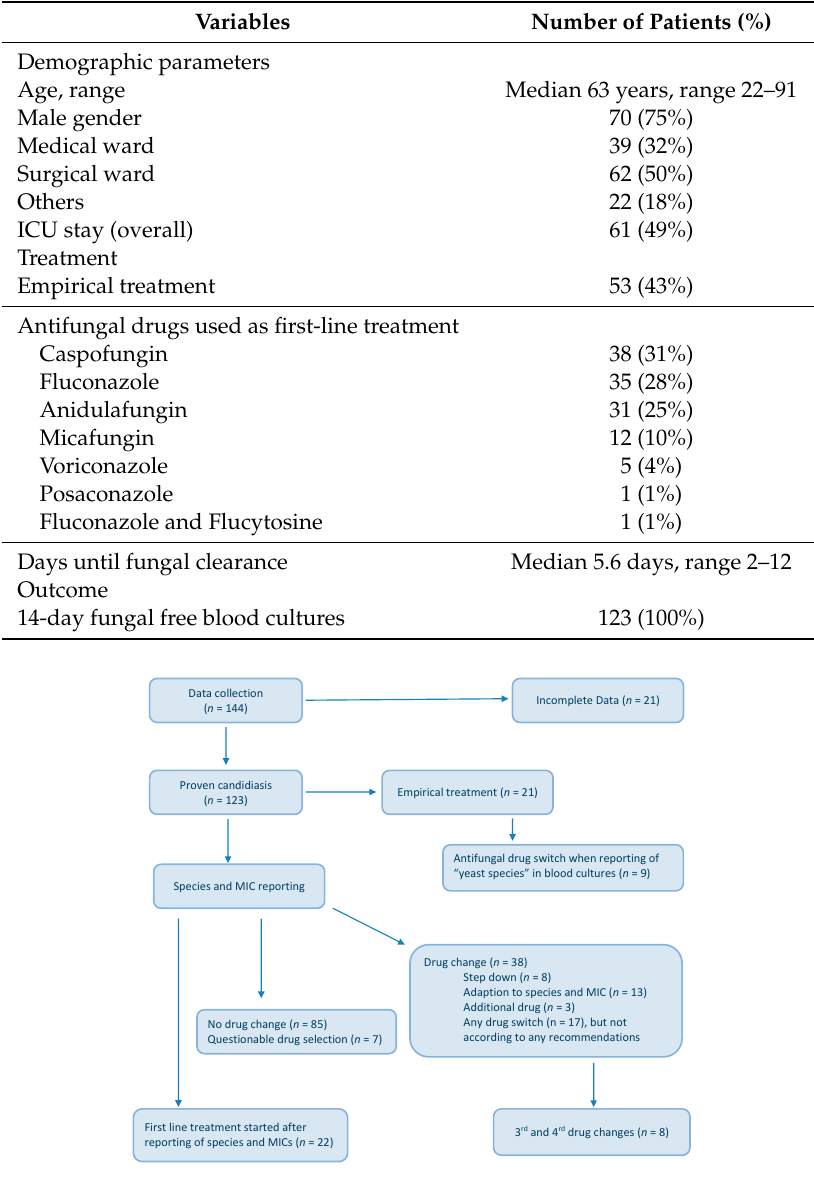
Table 2. Demographic and clinical characteristics of 123 patients with proven yeasts infections receiving antifungal therapy.